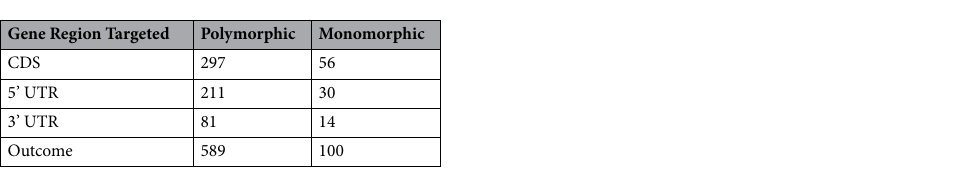
Table 4. Overall wet lab validation results of 862 TF-SSRmarkers of Tea. *173 TTFMS loci did not shown amplification.